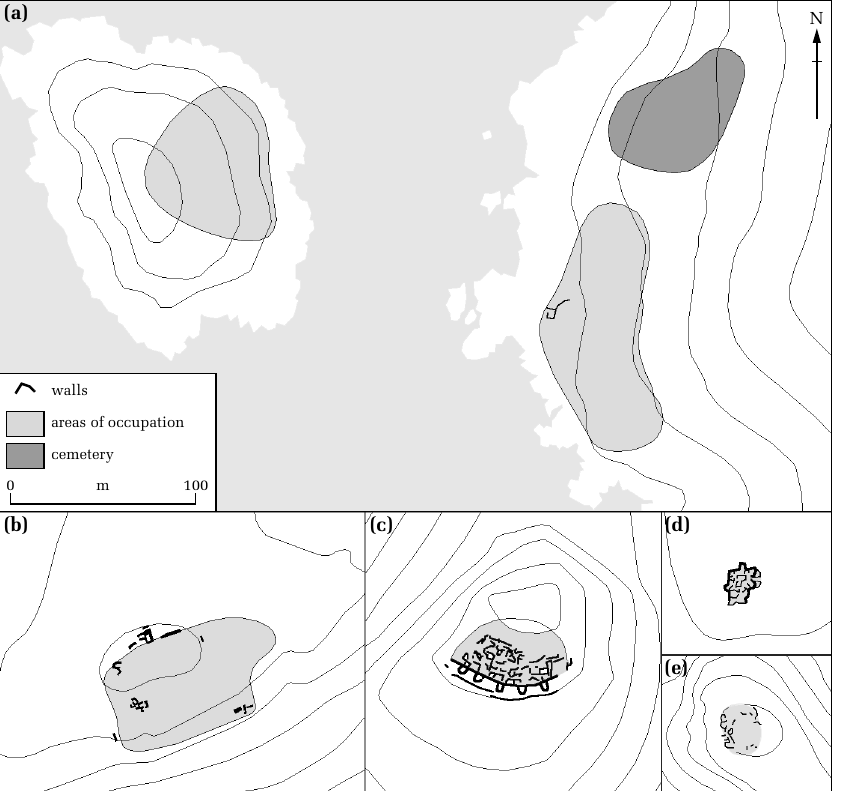
Figure 5 A comparison of the areal extent of the Early Bronze Age Cycladic sites of (a) Dhaskaleio on Keros, (b) Markiani on Amorgos, ( c) Kastri on Syros, (d) Panormos on Naxos, and (e) Mount Kynthos on Delos (contour intervals